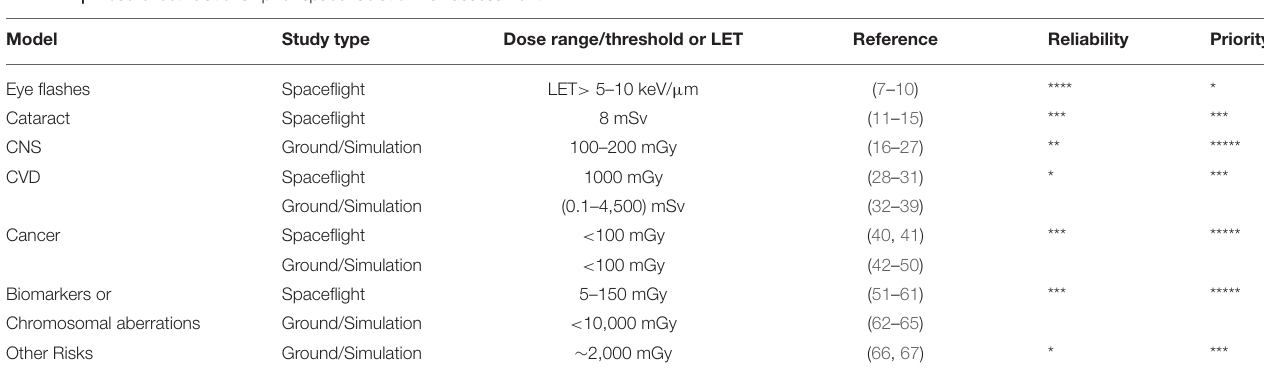
TABLE 1 | Dose-effect relationship for space radiation risk